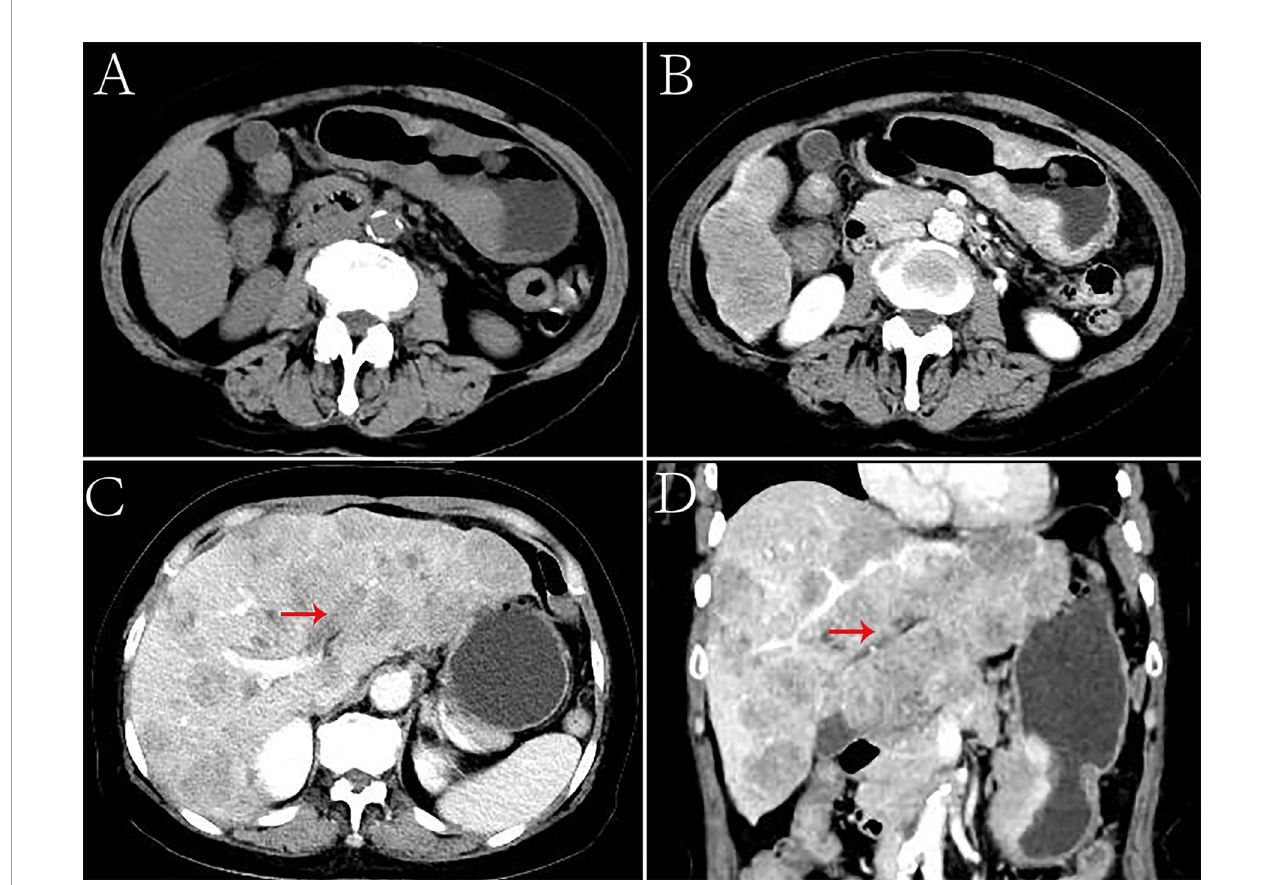
FIGURE 4 | Hepatoid adenocarcinoma of the stomach with embolization of the left branch of the portal vein in a 70-year-old woman. (A) Unenhanced computed tomography (CT) image of the stomach showing an intraluminal mass of inhomogeneous attenuation, with an undercooling boundary, in the cardia and fundus. The CT attenuation was approximately 41 Houns fi eld units (HU). Multiple nodular low-density metastases of different sizes were found in the liver. (B – D) Contrast- enhanced CT image showing obvious inhomogeneous enhancement of the mass. The thickest diameter of the mass was 3.3 cm. The Borrmann classi fi cation was type III. The arterial and venous phases showed a similar CT attenuation (approximately 91 HU). Intrahepatic metastases showed mild to moderate enhancement on enhanced CT. The left branch of the portal vein had no obvious changes, and low-density emboli could be seen in the lumen. (C) Portal phase of the contrast- enhanced image. (D) Portal phase of the contrast-enhanced coronal